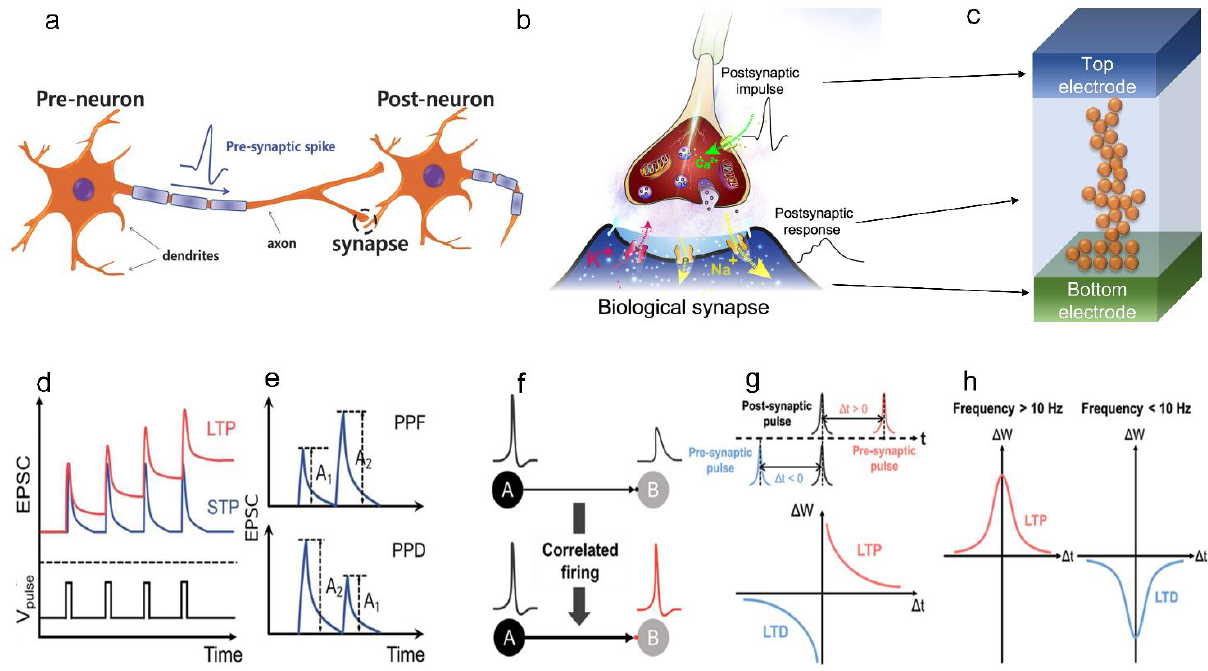
Figure 5. Comparison between biological and artificial synapses. ( a ) Biological synapse, pre-neuron, and post-neuron; adapted with permission from ref. [89], copyright 2016 Wiley-VCH Verlag GmbH & Co. ( b ) Schematic of an artificial synapse; adapted with permission from ref. [77], copyright 2021 Springer Nature. ( c ) General model of a two-terminal memristor-based artificial synapse. ( d ) Long- term potentiation (LTP) and short-term potentiation (STP) of artificial synapses are shown in red and blue, respectively. ( e ) Paired pulse facilitation (PPF) and paired pulse depression (PPD) in arti- ficial synapses. ( f ) Schematic of the Hebbian learning model. ( g ) Spike time-dependent plasticity (STDP) according to the relative timing of the pre- and post-synaptic pulses. ( h ) Spike rate-depend- ent plasticity (STRP) for long-term potentiation (LTP) and long-term depression (LTD) occurring under distinct conditions; adapted with permission from ref. [101], copyright 2021 Wiley-VCH Ver- lag GmbH & Co.